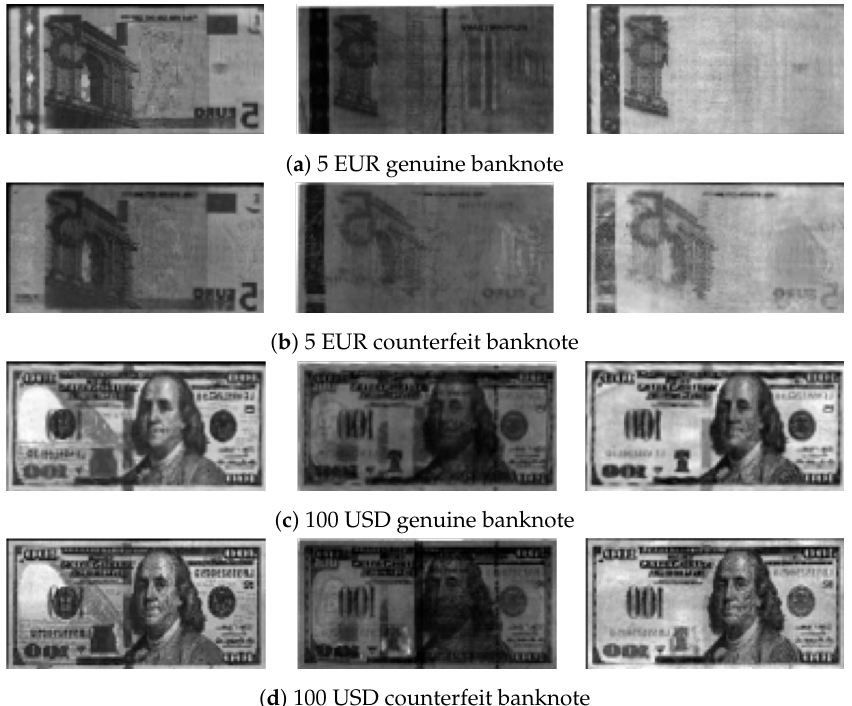
Figure 3. Different modality images. Leftmost column shows visible, center column shows infrared transmission, and rightmost column shows infrared reflection